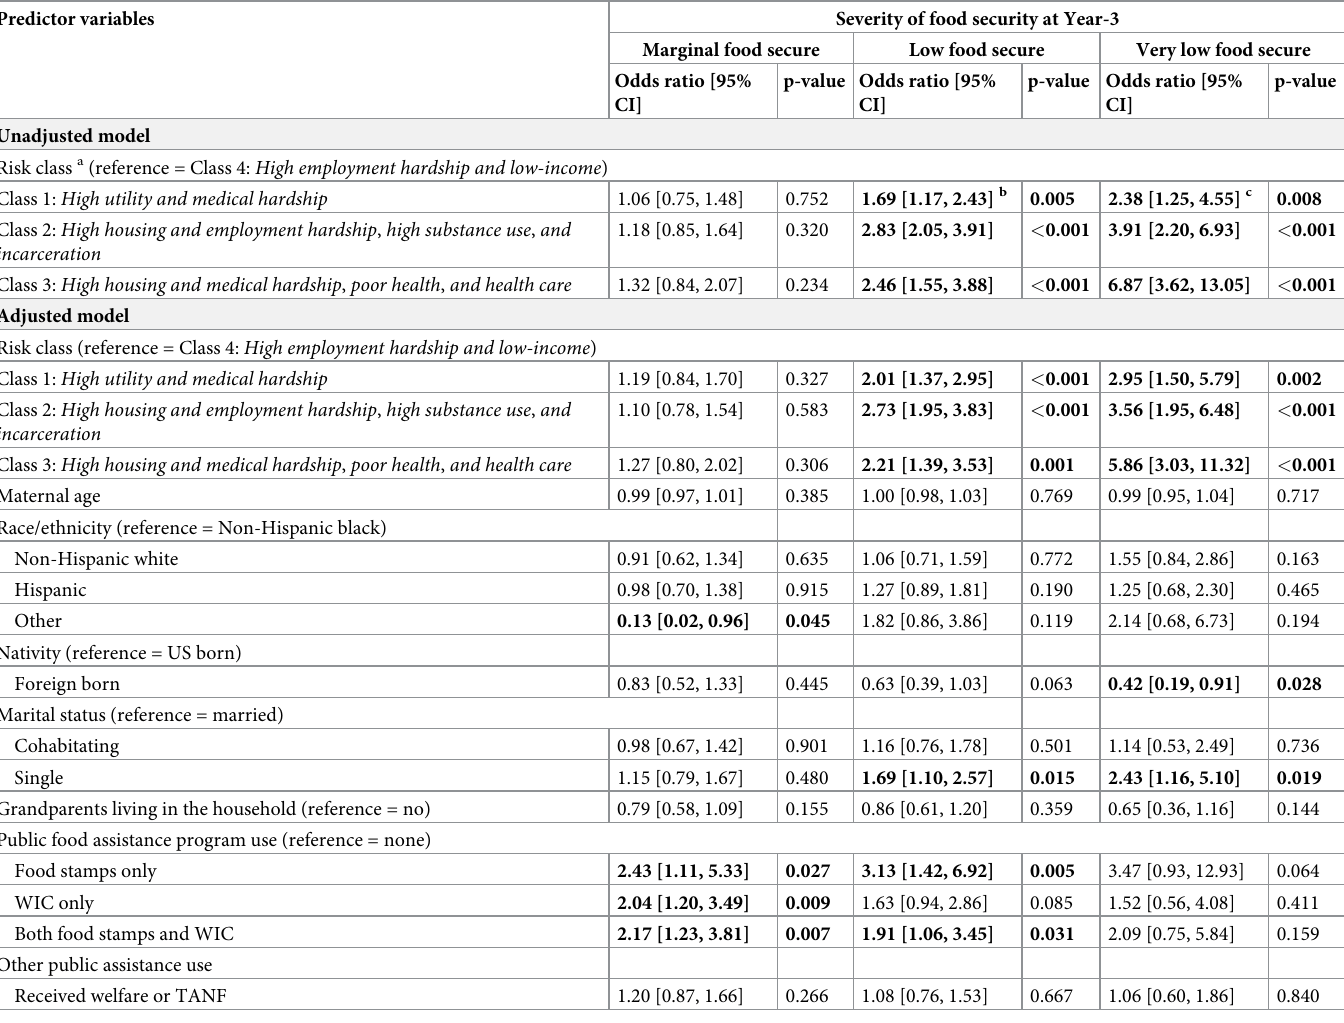
Table 5. Multinomial logistic regression analysis for latent risk classes predicting level of food security at Year-3 (n = 1,853). Predictor